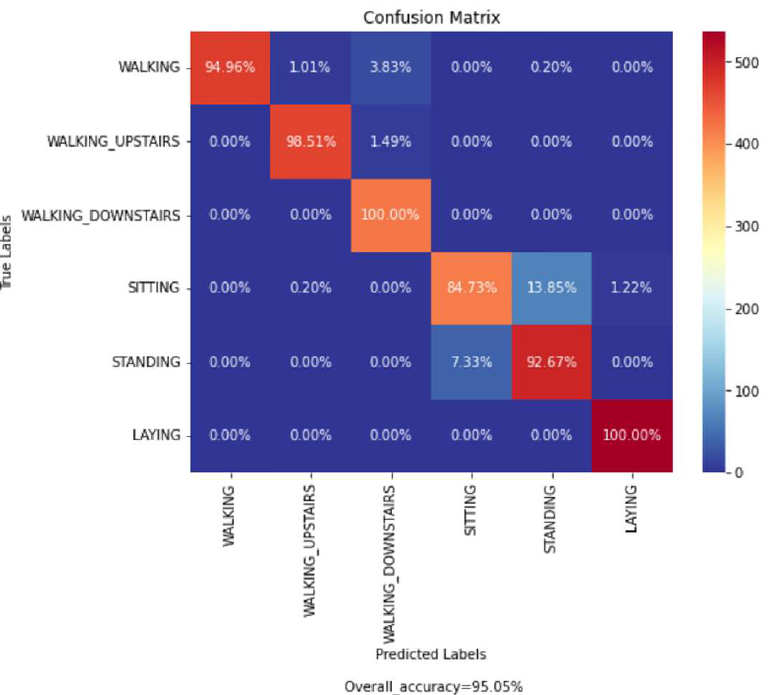
Figure 18. Confusion matrix achieved from the evaluation of our proposed Ensem-HAR model on the UCI-HAR dataset.